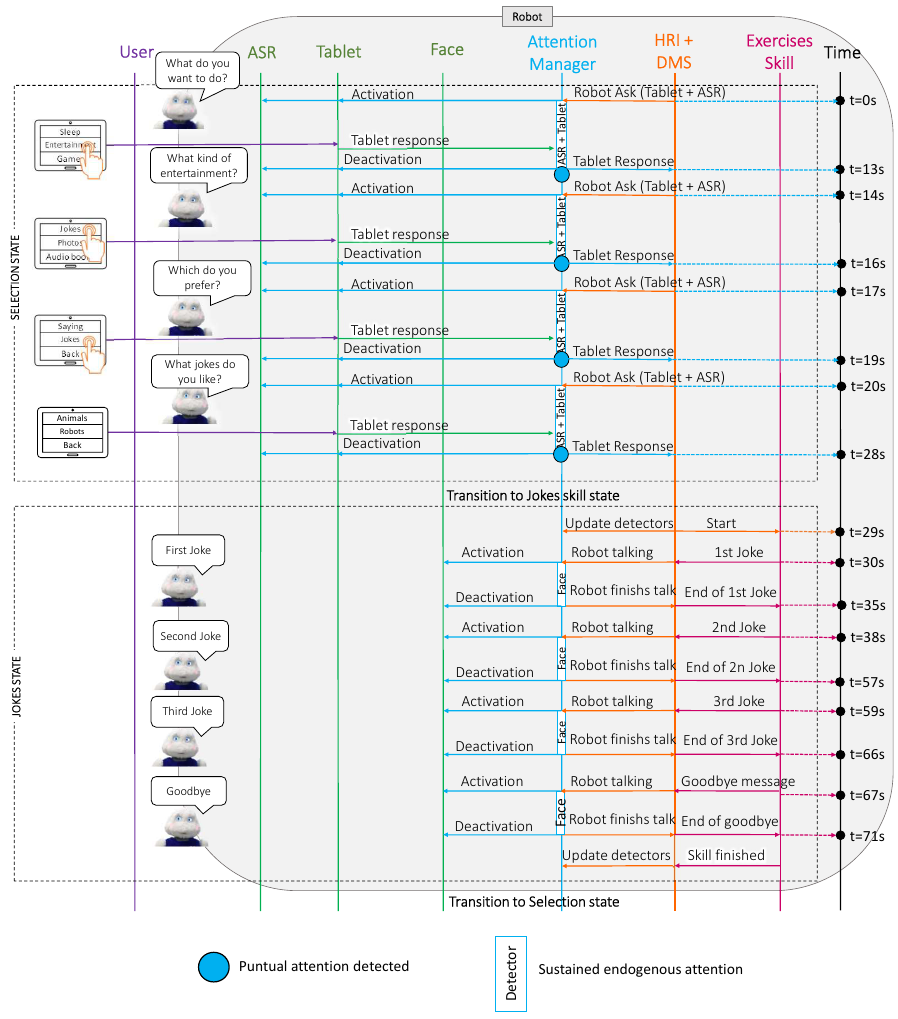
Figure 6. A sequence diagram of the connections between the different software blocks in the Mini during the execution of the joke telling skill. The blue boxes in the attention manager row display sustained attention from the detectors. The blue dots show the punctual attention that was produced by the user’s